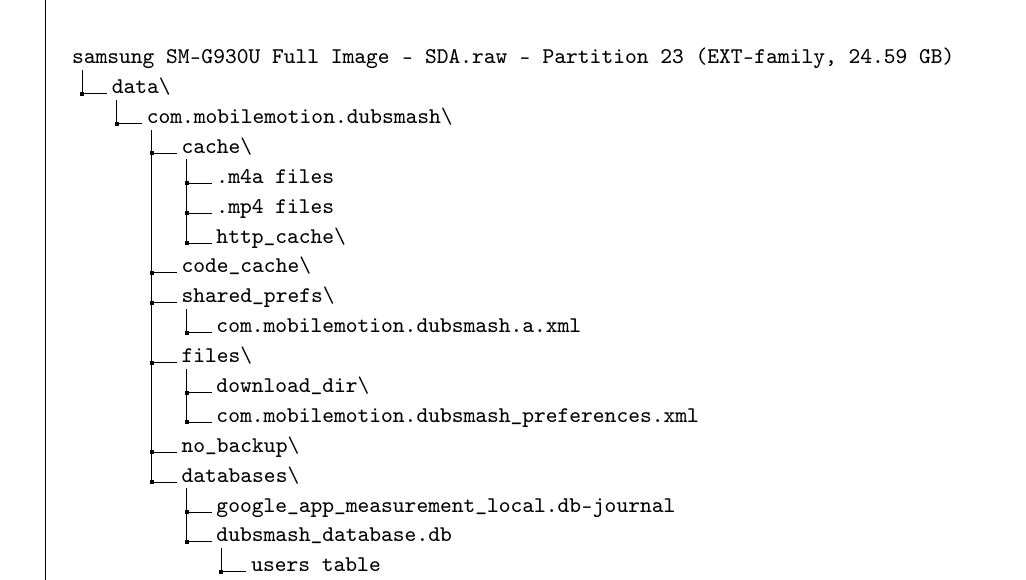
Figure 14. Dubsmash Android file structure as captured in Magnet AXIOM